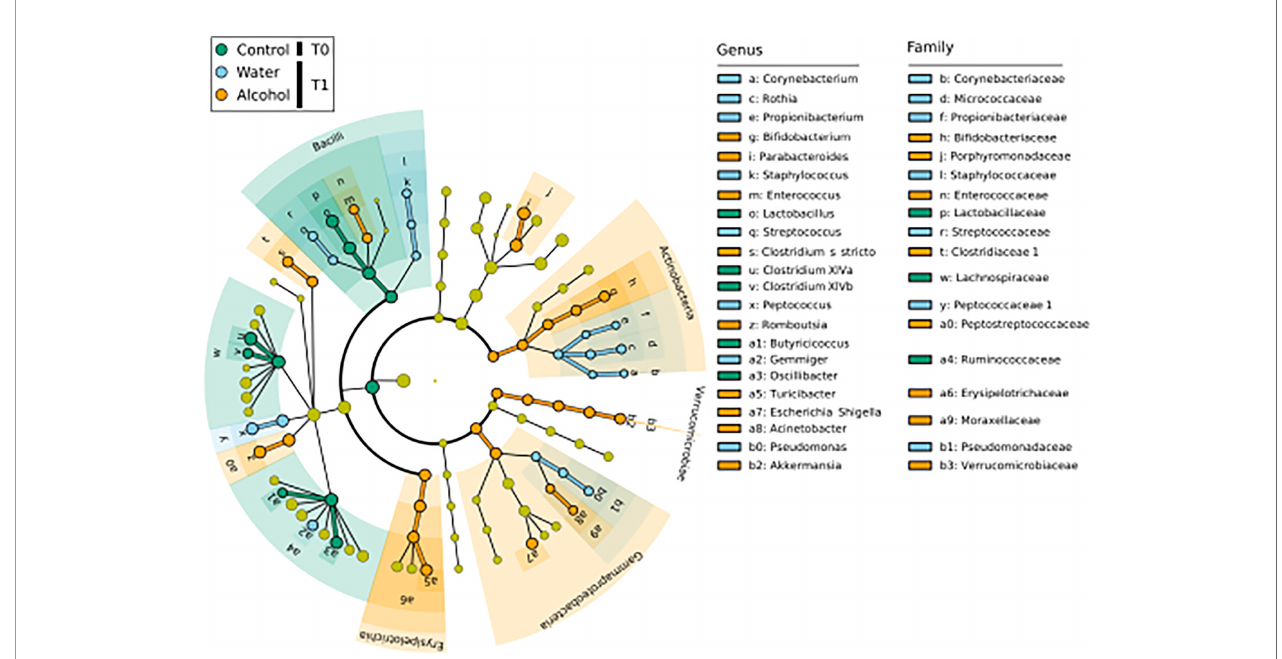
FIGURE 2 | LEfSe biomarker identi fi cation for the comparison of genera relative abundance between the T1 ethanol-administered rats, the T1 water-administered rats, and the corresponding T0 samples. Signi fi cant biomarker taxon for each group was obtained with a Kruskal – Wallis test among classes ( a = 0.05], and only biomarkers with a logarithmic linear discriminant analysis score higher than 2.0 were retained. T0 group, n = 14; water group, n = 6; alcohol group, n =